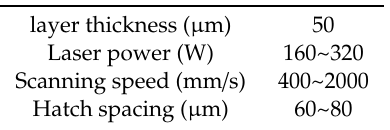
Table 1. The list of SLM processing parameters.